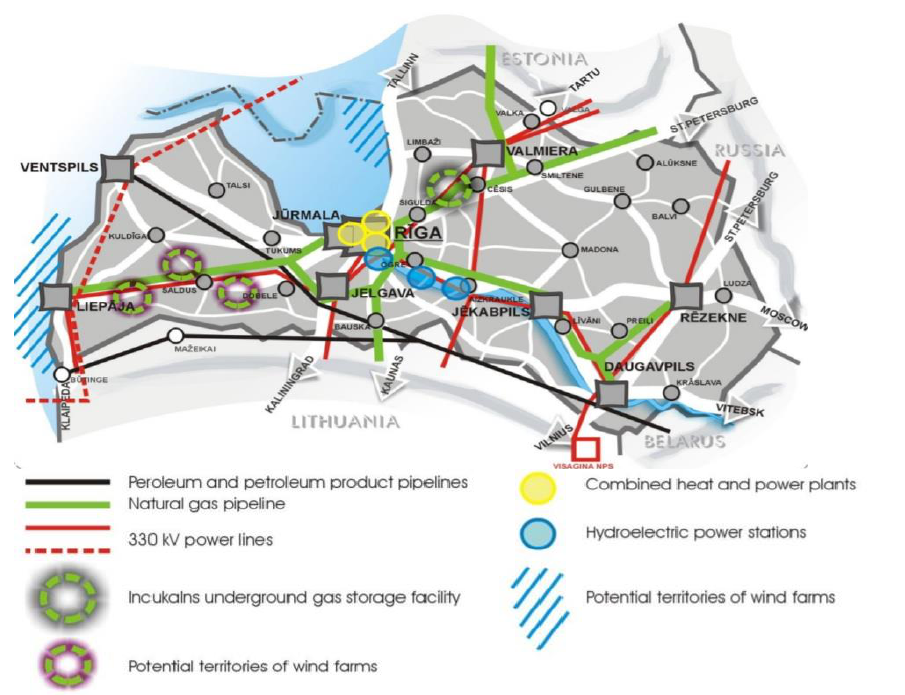
Fig. 2. Renewable and safe energy (2010) (Rubina, 2010, Riga